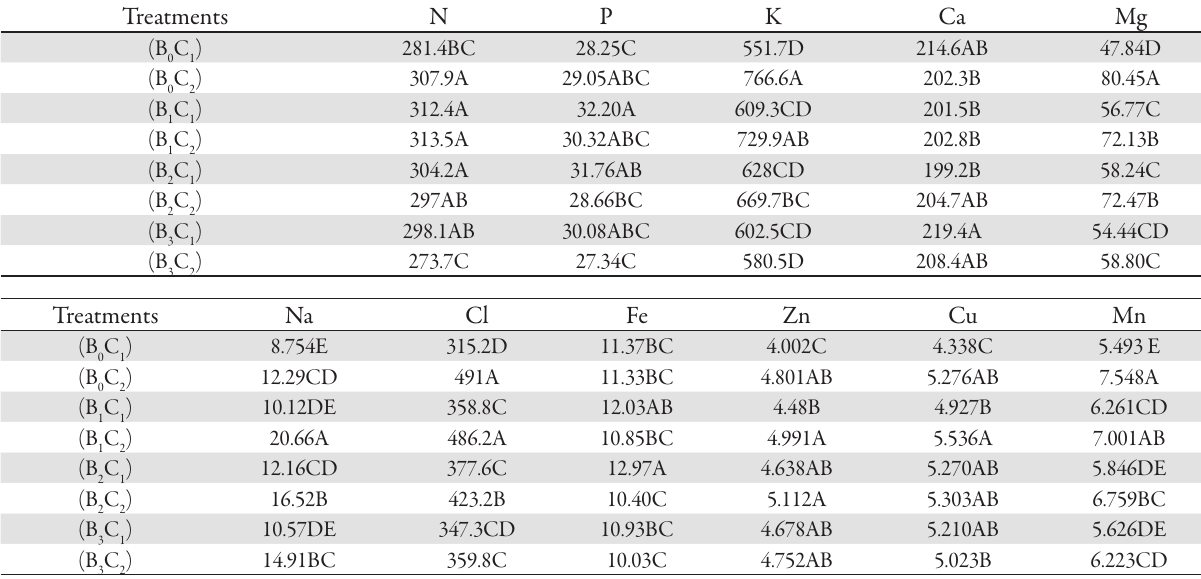
Tab. 7. The comparison of mean for the interaction effect between bacterium and cultivar on uptake of macro and micro elements and elements of Na and Cl (mg pot -1